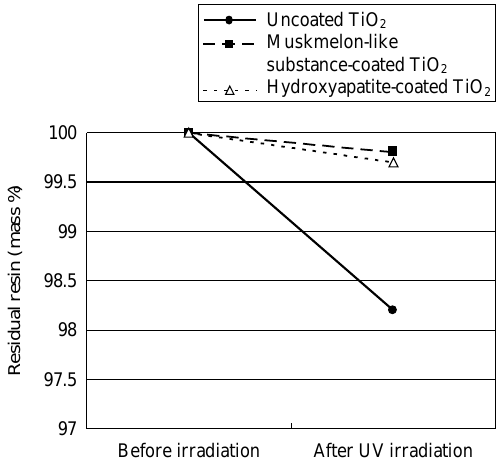
Resin substance decomposition inhibition effect with coated TiO 2 photocatalyst